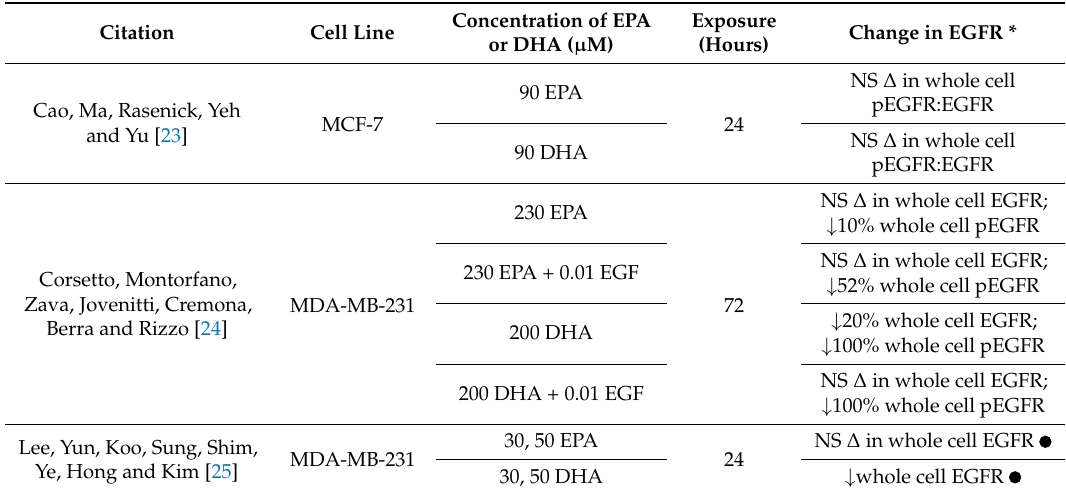
Table 8. Comparison of DHA and EPA on total amounts of EGFR and pEGFR in whole cell lipids and lipid rafts in human BC cell lines.